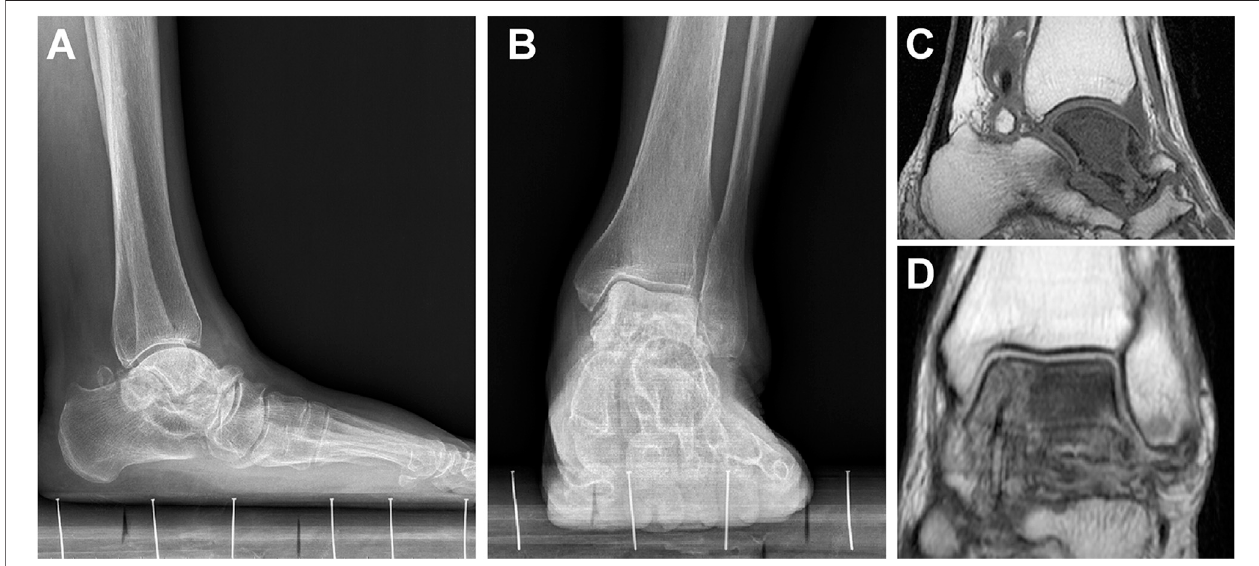
FIGURE 1 | Preoperative weight-bearing anteroposterior and lateral views of patient 1 (A,B) . TAN was con fi rmed by magnetic resonance imaging (C,D) .